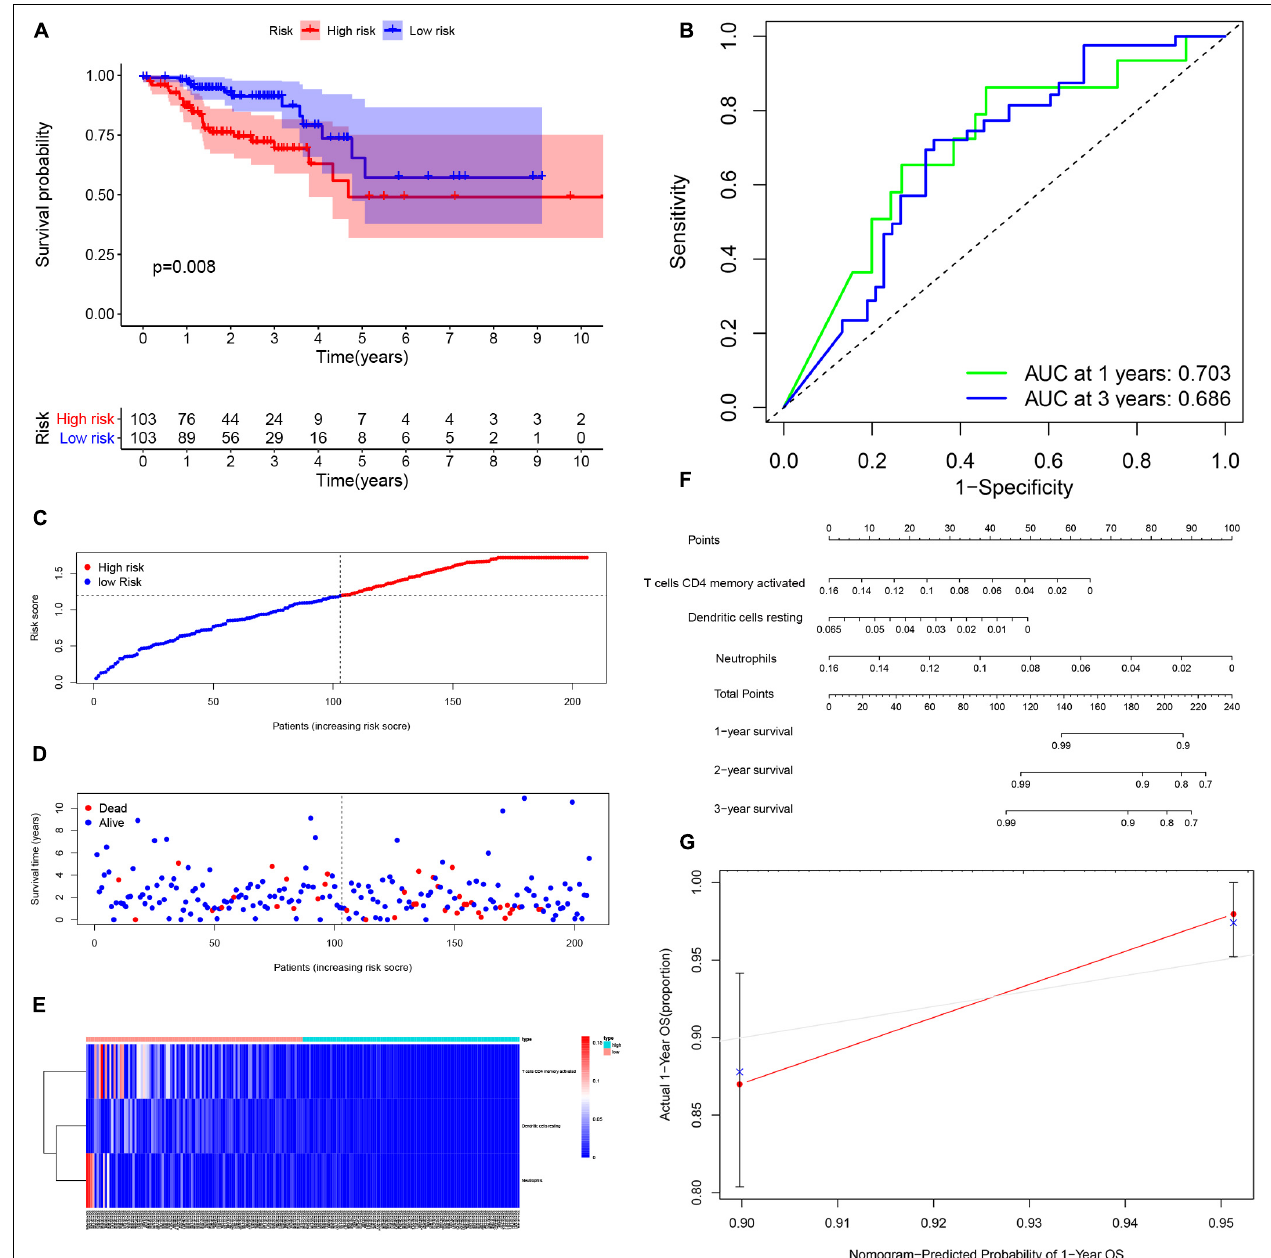
FIGURE 10 | Performance of the infiltrating immune cells prognostic model.Survival analysis was plotted to visualize survival probability of low-risk and high-risk patients (A) . ROC curve was used to verify the accuracy of the model (B) . Distribution of groups based on the risk score (C) . Survival status of patients in different groups (D) . Heatmap was plotted to visualize 3 prognostic related infiltrating immune cells between low-risk and high-risk patients (E) . Nomogram graph was used to predict patients’ survival time (F) . Calibration curve of the nomogram (G)